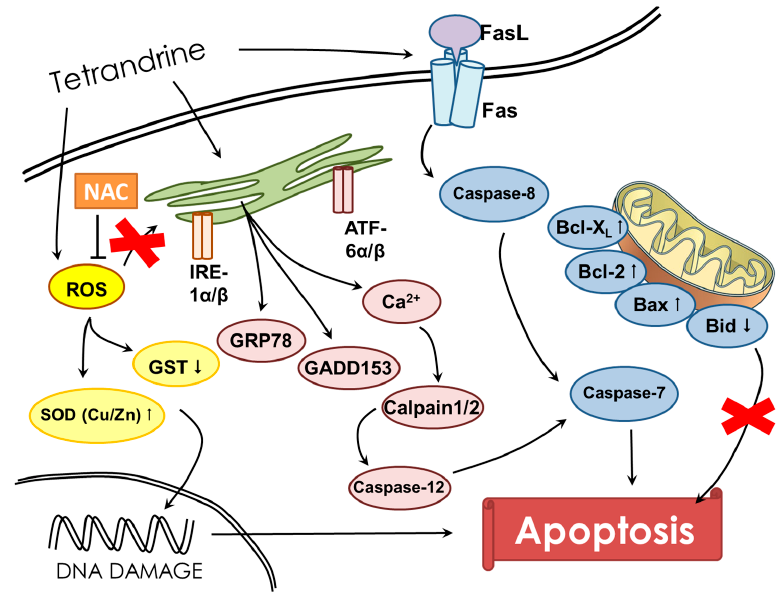
Figure 7. The possible signaling pathways for tetrandrine-induced apoptosis in NPC-TW 076 human nasopharyngeal carcinoma cells.